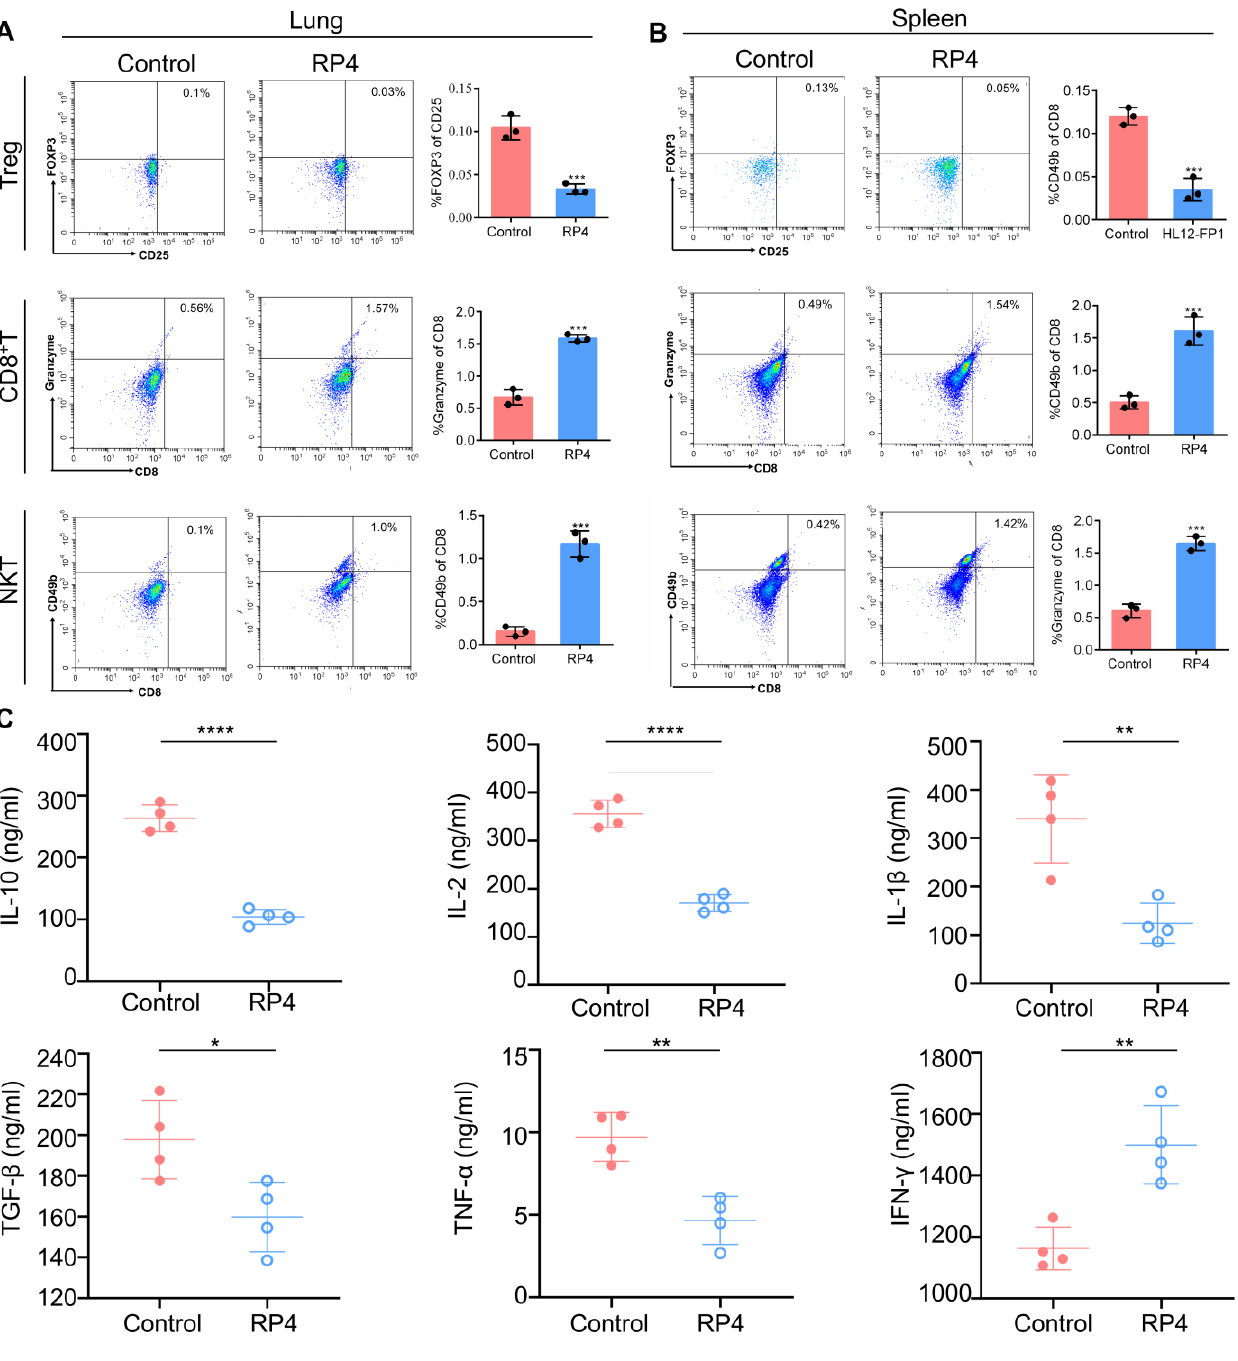
Figure 7. RP4 suppresses lung metastasis by reprogramming the regulation of immune cell activities. ( A ), Flow cytometry analysis of Treg, CD8 + T, and NKT cells infiltration in the lung. ( B ), Flow cytometry analysis of Treg, CD8 + T, and NKT cells infiltration in the spleen lymph node. ( C ), ELISA analysis of IL-10, IL-2, IL-1 β , TNF- α , and TGF- β . Data are expressed as mean ± S.D. Statistical analysis was performed with t test ( n = 3; * p < 0.05, ** p < 0.01, *** p < 0.001, **** p < 0.0001). Representative images from three independent experiments are shown.